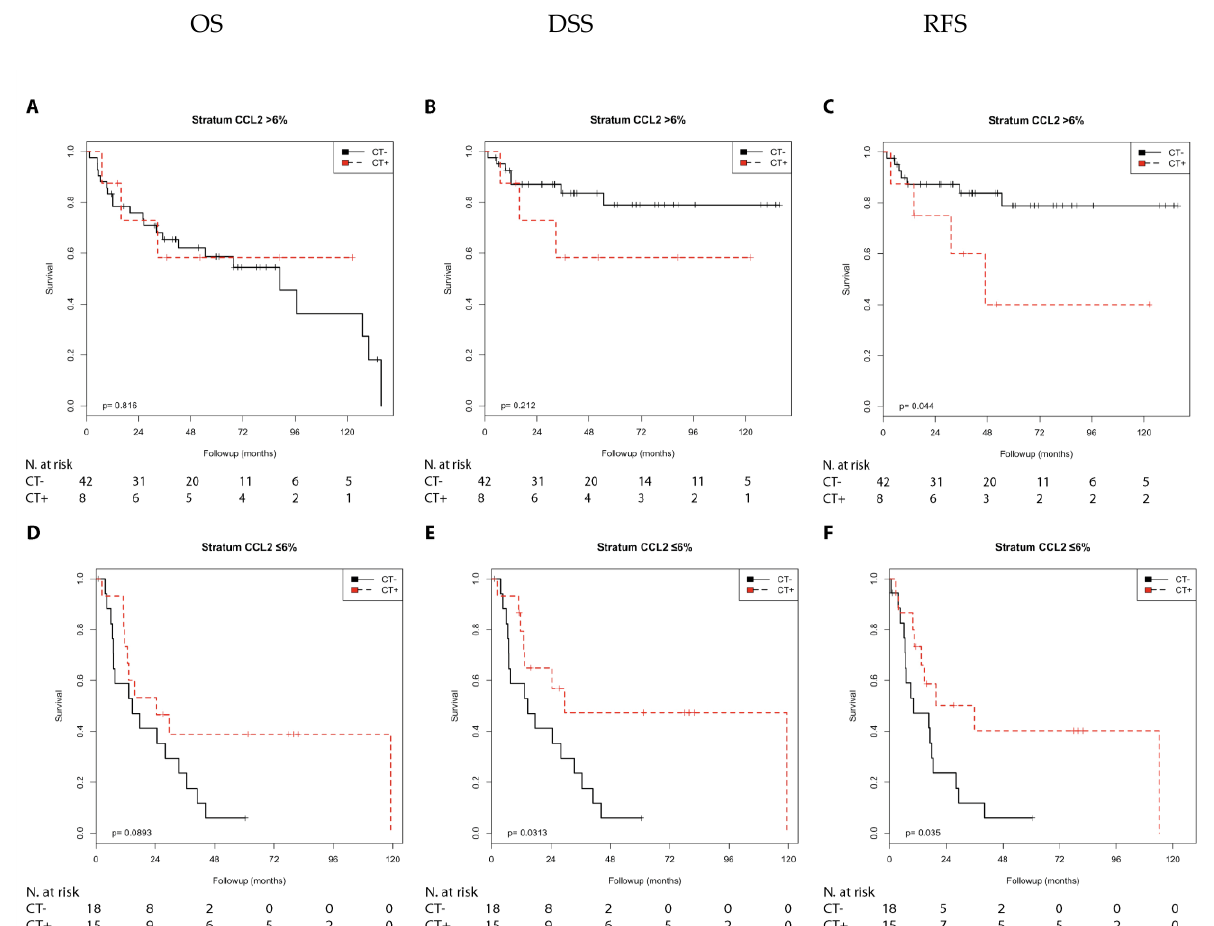
Figure 3. Kaplan–Meier analysis: Association of chemotherapy with prognosis (OS, DSS, and RFS) in the N0/N1 + 2 groups stratified by CCL2 expression (>6% or ≤ 6%). In the N0 group ( A – C ) with CCL2 (>6%), chemotherapy treatment was not associated with OS ( A ) or DSS ( B ) but was associated with shorter RFS ( C ; p = 0.044). In the N1 + 2 group ( D – F ) with CCL2 ( ≤ 6%), chemotherapy was not associated with OS ( D ) but was associated with longer DSS ( E ; p = 0.031) and longer RFS (F; p = 0.035).